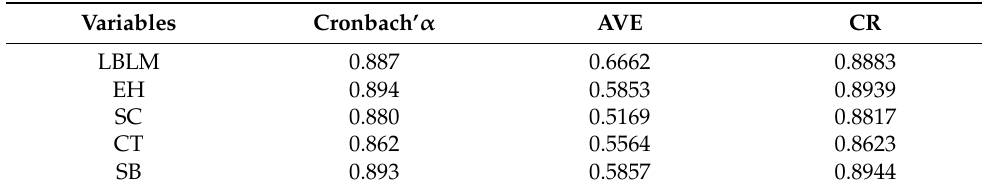
Table 3) that the five-factor model had the best fit ( χ 2 /df = 1.527, CFI = 0.972, TLI = 0.969, RMSEA = 0.035, SRMR = 0.038), and the one-factor model had a poor fit, indicating good discriminant validity for the data. Table 2. Reliability and convergent validity (N = 422).